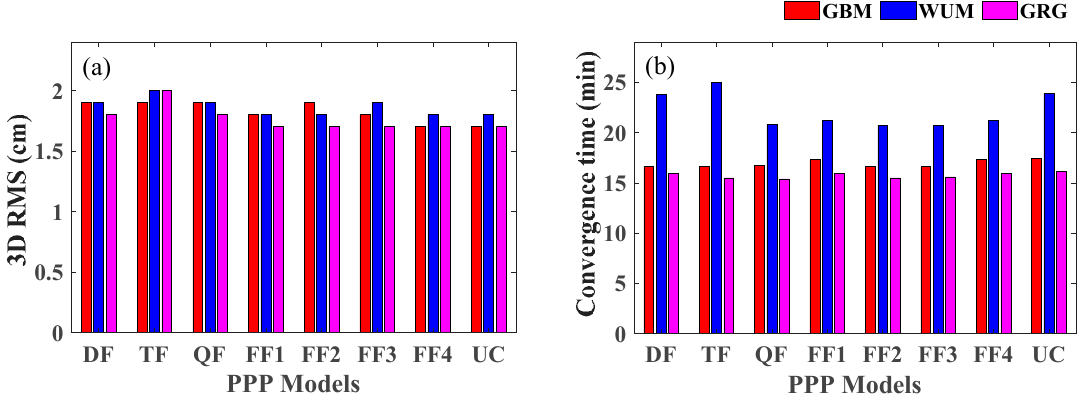
Figure 12. Average 3D RMS values and average convergence times by using the GBM, WUM and GRG precise product PPP solutions on DOYs 190 to 196 in 2020. ( a ) 3D RMS value; ( b ) convergence time.